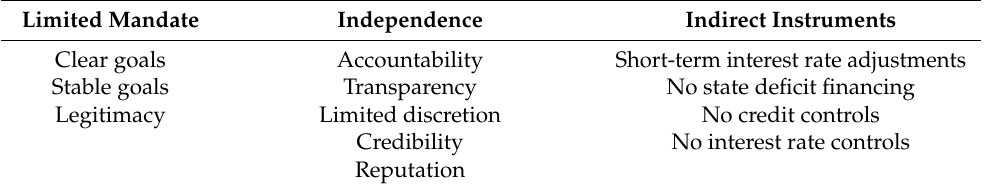
Table 1. The traditional central banking template: tensions and